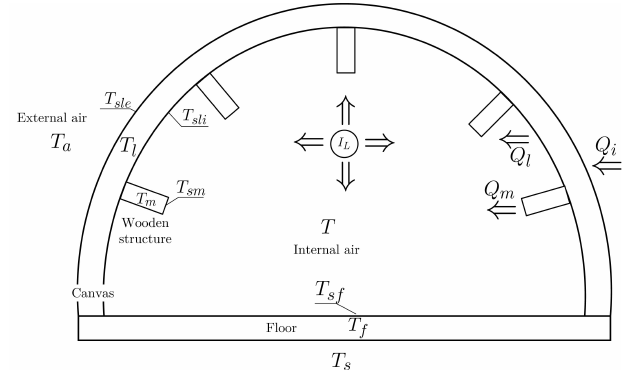
Figure 2. Cross section of the dome and model variables. Canvas temperature ( T l ), wooden structure temperature ( T m ), floor temperature ( T f ), internal air temperature ( T ), environmental temperature ( T a ), ground temperature ( T s ), superficial external and internal canvas temperature ( T sle and T sli ), superficial wooden structure temperature ( T sm ), superficial floor temperature ( T sf ), internal loads ( I L ) , heat flux transferred by the canvas and the wooden structure ( Q l and Q m ), incoming heat flux ( Q i ) .